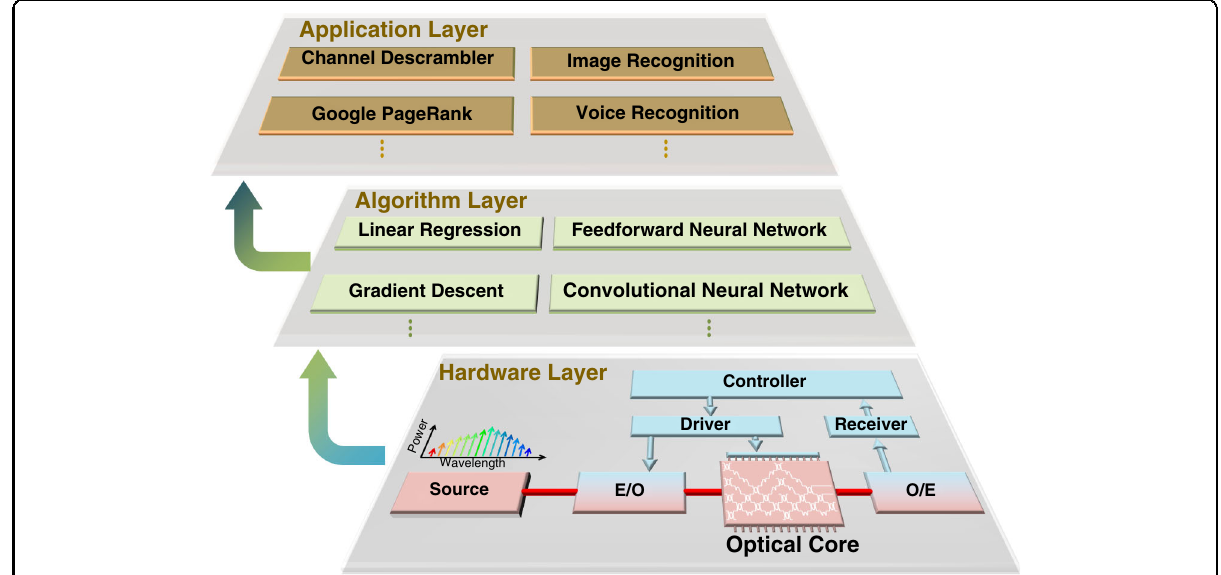
Fig. 14 Optoelectronic-hybrid AI. Schematic diagram of the optoelectronic-hybrid AI computing chip